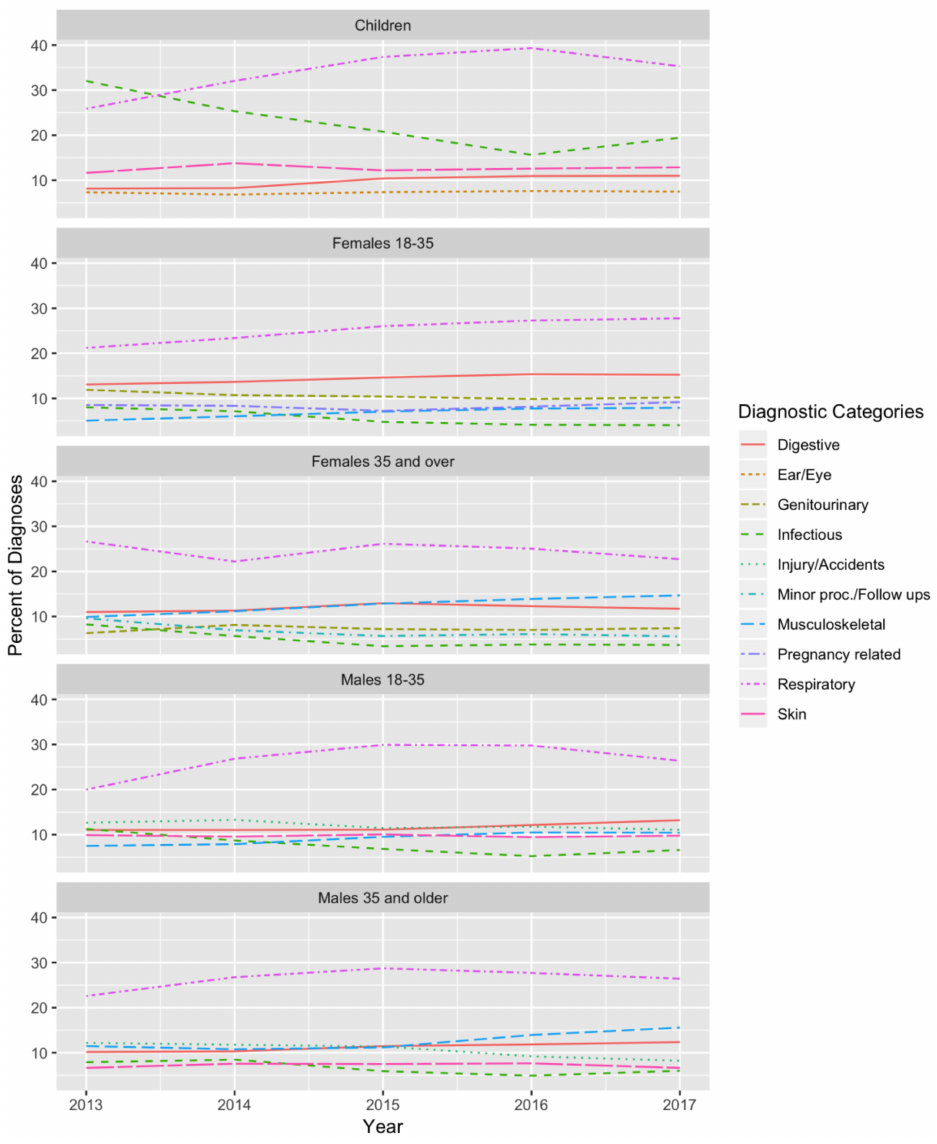
Figure 1. Percent of total diagnoses in each diagnostic category by age and gender over